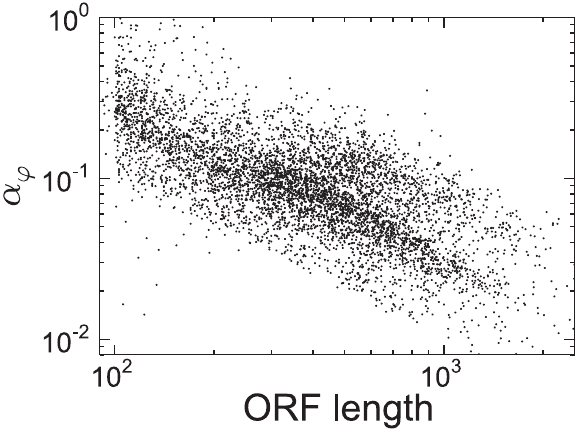
Figure 3. Scatter plot of the ORF lengths L against the estimated a Q ’s. The log-log scatter plot shows possible signatures of